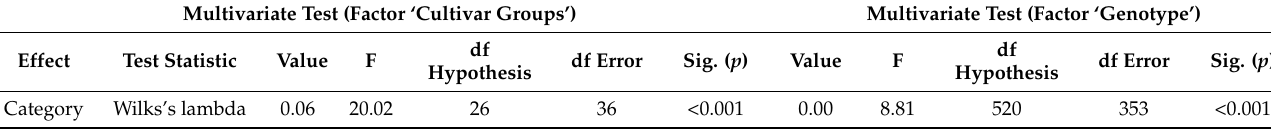
Table 2. MANOVA analysis considering as ‘factor’ the cultivar groups (‘Re Fiascone’ and ‘San Marzano’) and the 21 studied accessions (factor =